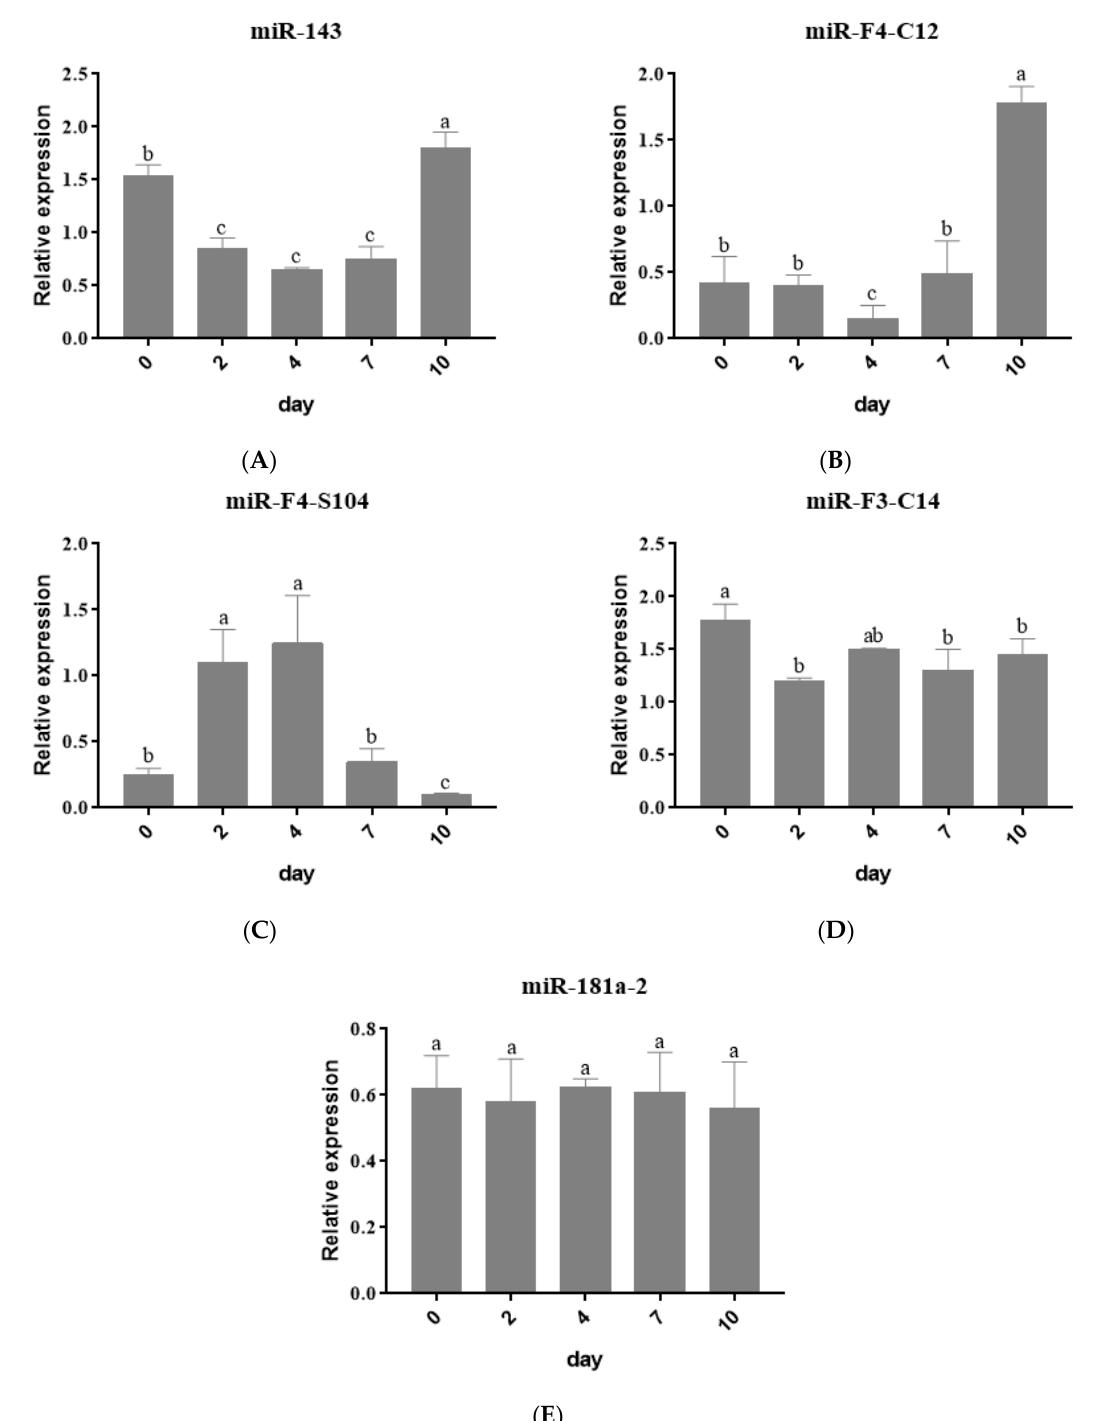
Figure 2. Expression levels of miRNAs in differentiation adipocytes. The expression level of five mature miRNAs at different induction times in 3T3-L1 cells. U6 as a loading control. ( A ) miR-143, ( B ) miR-F4-C12, ( C ) miR-F4-S104, ( D ) miR-F3-C14, ( E ) miR-181a-2. Results are shown as means ± SD of triplicate measurements. Different letters indicate a significant difference ( p < 0.05).